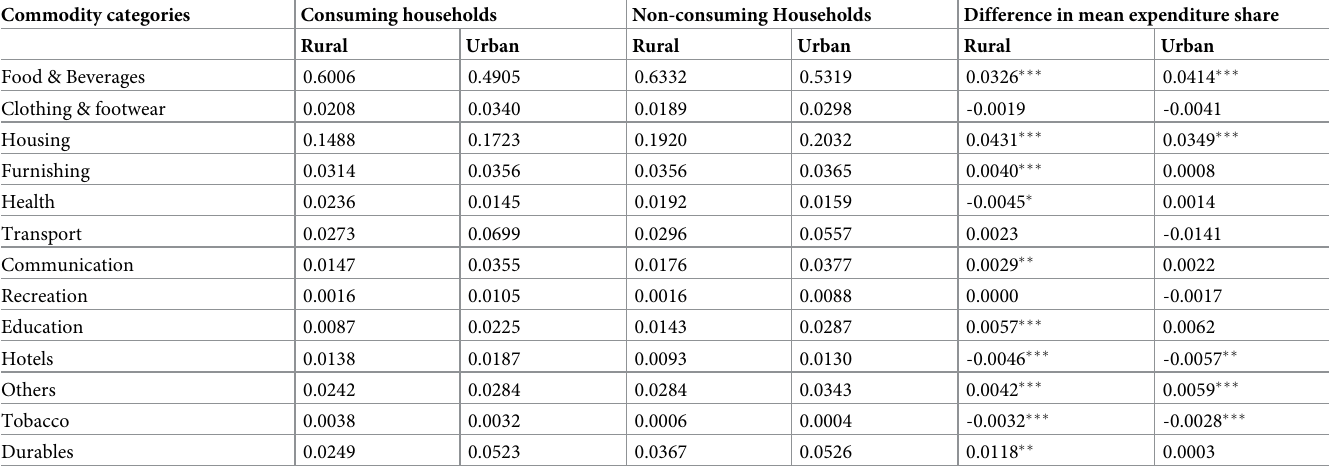
Table 3. T-Test for the differences in mean of shares between alcohol consumers and non-consumers for Rural and Urban households.